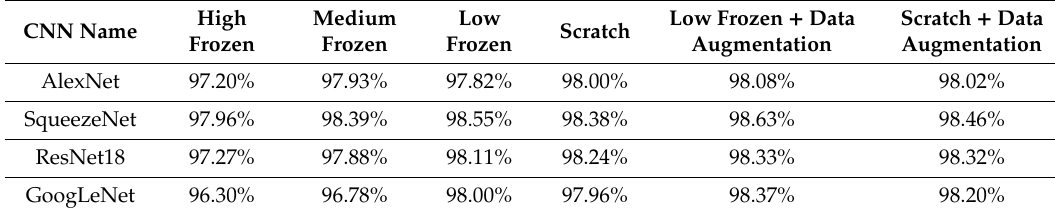
Table 5. Best AUC results.